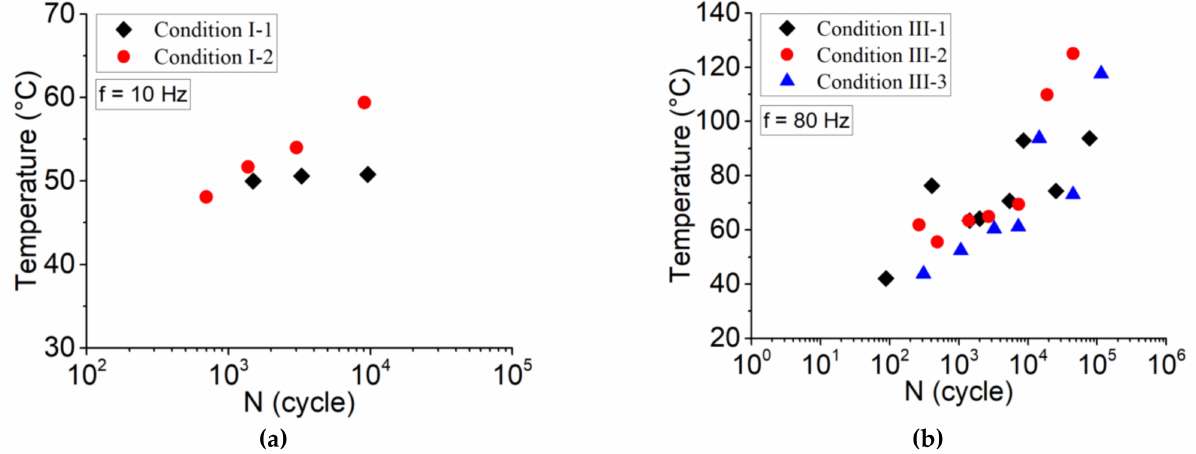
Figure 12. Maximum induced temperature evolution versus number of cycles according to ( a ) condition I at frequency of 10 Hz and ( b ) condition III at frequency of 80